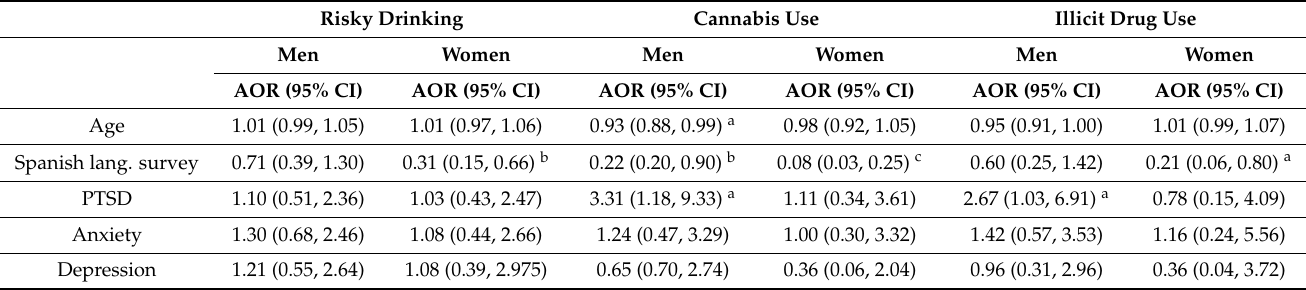
Table 3. Associations between mental health problems and substance use.